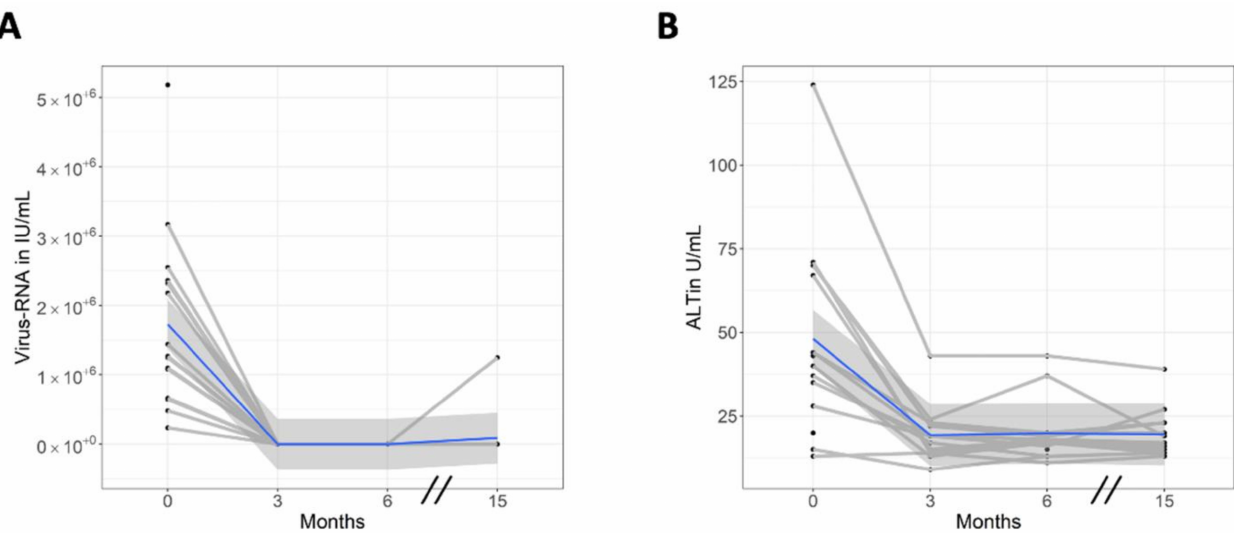
Figure 3. Laboratory results after antiviral treatment. ( A ) Viral load; complete viral clearance was achieved in all patients ( n = 15) by 1 month after treatment initiation. The high value at 15 months (FU2) represents the single patient with viral relapse (first and second relapse 21 days after end of treatment (EOT) and 18 days after prolonged treatment are not shown); this patient had been HCV-negative for 3 months (EOT) and 6 months (FU1) after prolonged antiviral therapy (see text). ( B ) Alanine aminotransferase (ALT) was found to have decreased at the 3-month measurement, corresponding to EOT, and it showed constant low values during follow-up; this included the patient with viral